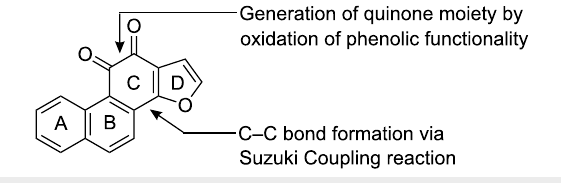
Figure 2: Key strategies for development of C-ring with quinone func- tionality.